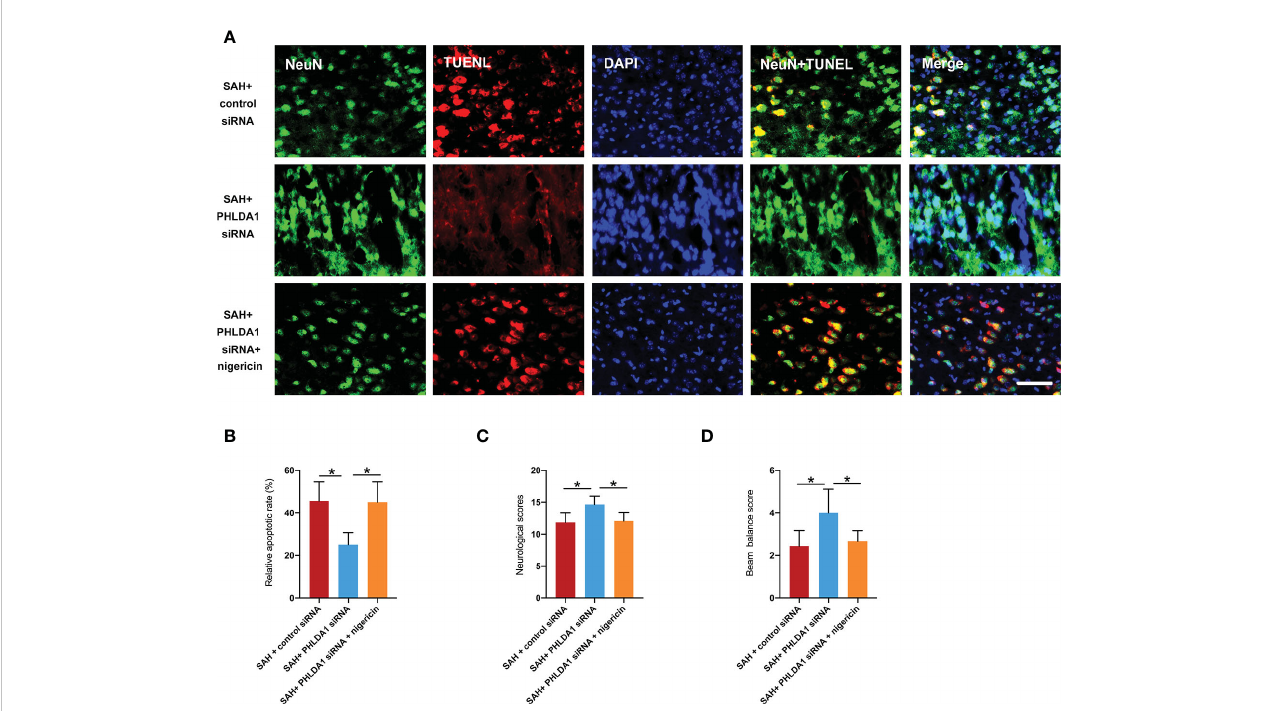
FIGURE 8 Nigericin administration abrogated the bene fi cial effects of PHLDA1 de fi ciency on neuronal survival and neurological function. (A) Representative immuno fl uorescence images of TUNEL staining in temporal cortex. (B) Quanti fi cation of TUNEL +/ NeuN + cells in temporal cortex (n = 6 per group). Nigericin administration aggravated neurological de fi cits (C) and motor dysfunction (D) after SAH (n = 9 per group). * P < 0.05. Scale bar=50 m m. Data are expressed as mean ±